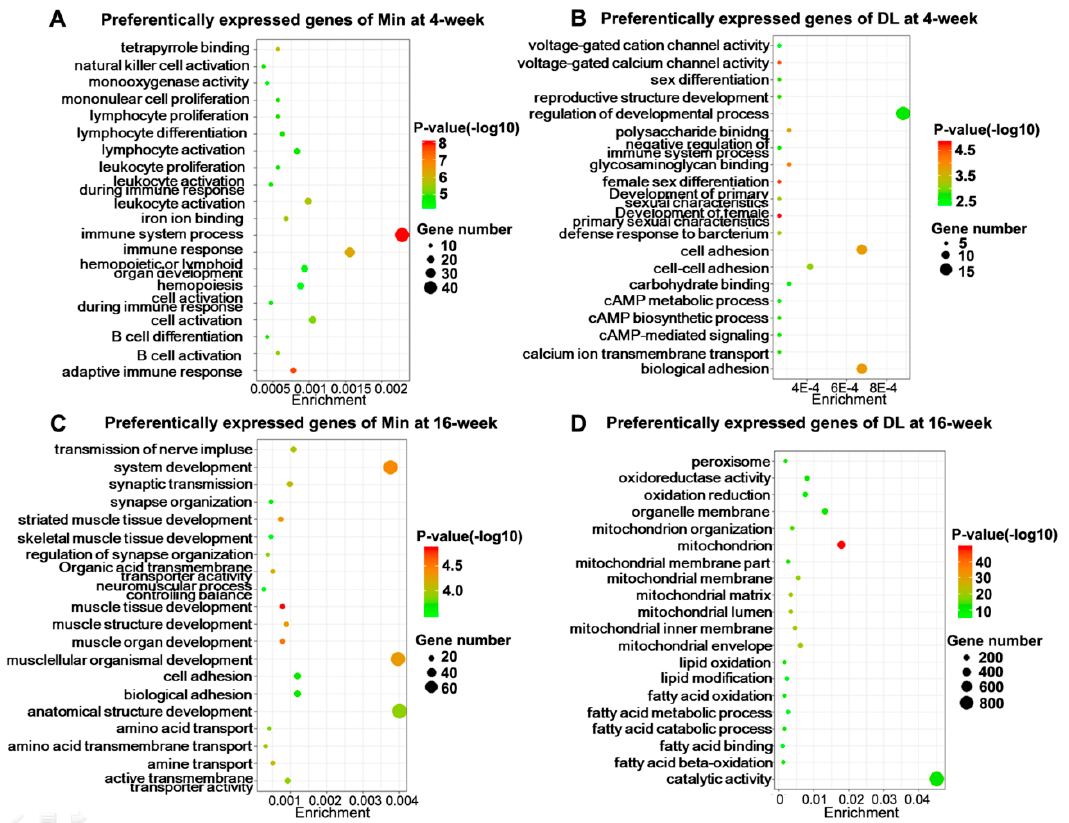
Figure 4. Gene Ontology (GO) enrichment of upregulated genes. GO enrichment of upregulated genes in 4-week-old Min ( A ), 4-week-old DL ( B ), 16-week-old Min ( C ), and 16-week-old DL ( D ) pigs. The X-axis provides the richness factor, which is calculated by dividing the upregulated gene number in a given GO term by the total gene number in the term of genome. The size and color of the bubbles represent gene number and enrichment significance according to hypergeometric testing, respectively.